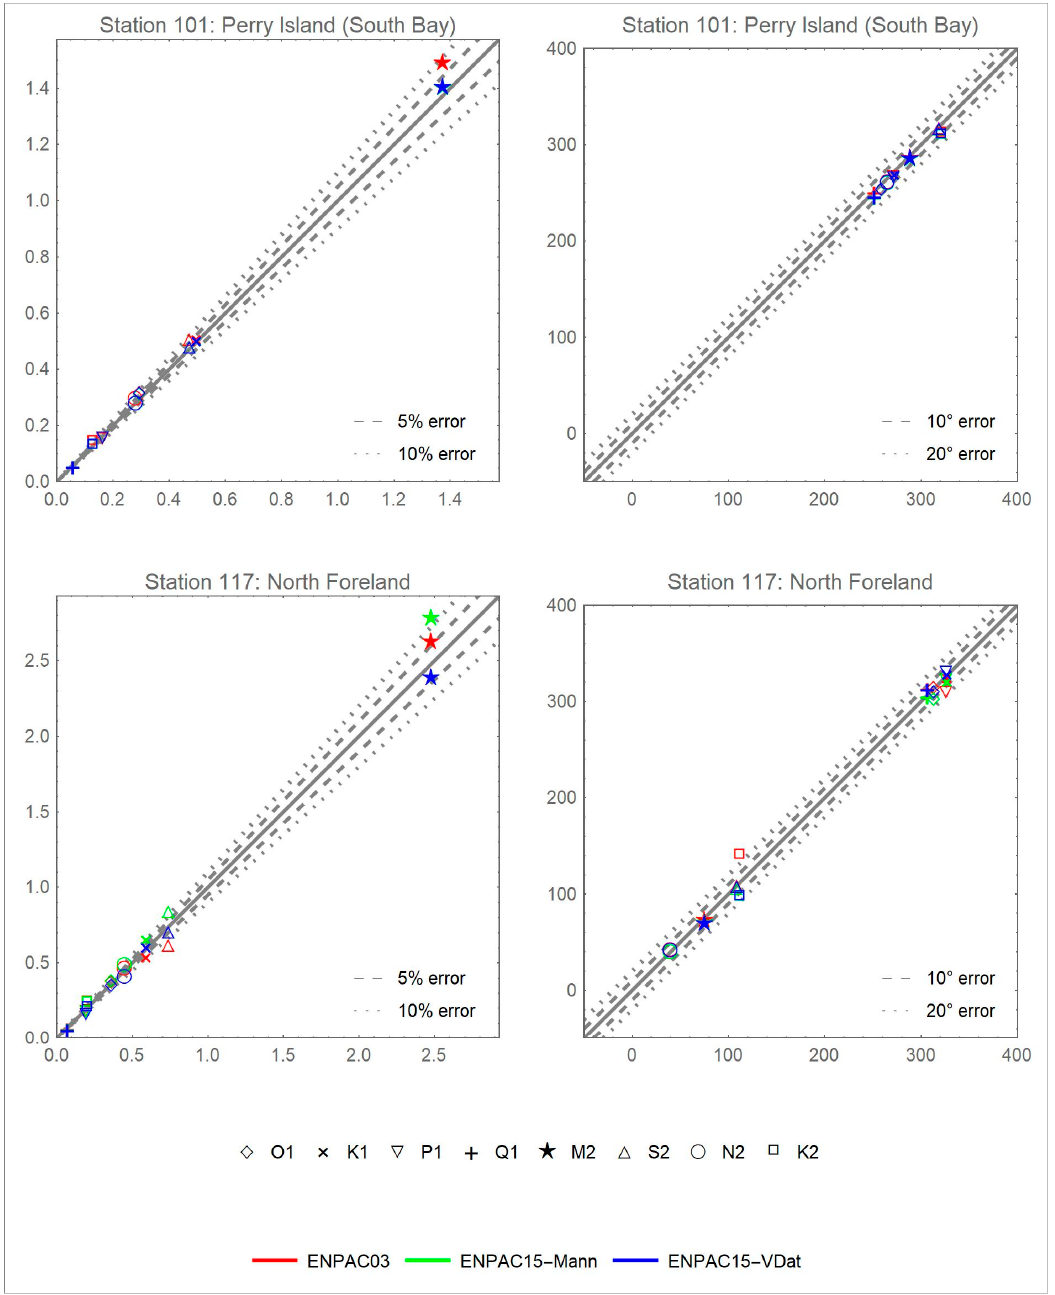
Figure A13. Scatterplots of errors for two Southern Alaska coast stations, locations shown in Figure A5.